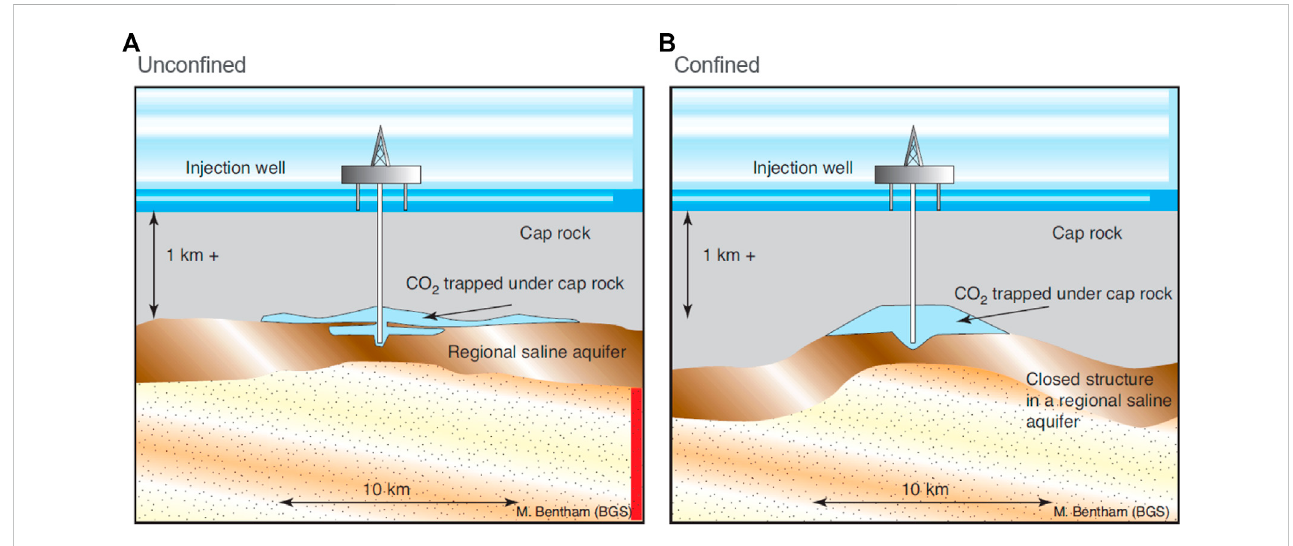
FIGURE 6 Conceptual representation of geologic CO 2 storage in open (A) and closed (B) saline aquifers (Bentham and Kirby, 2005).